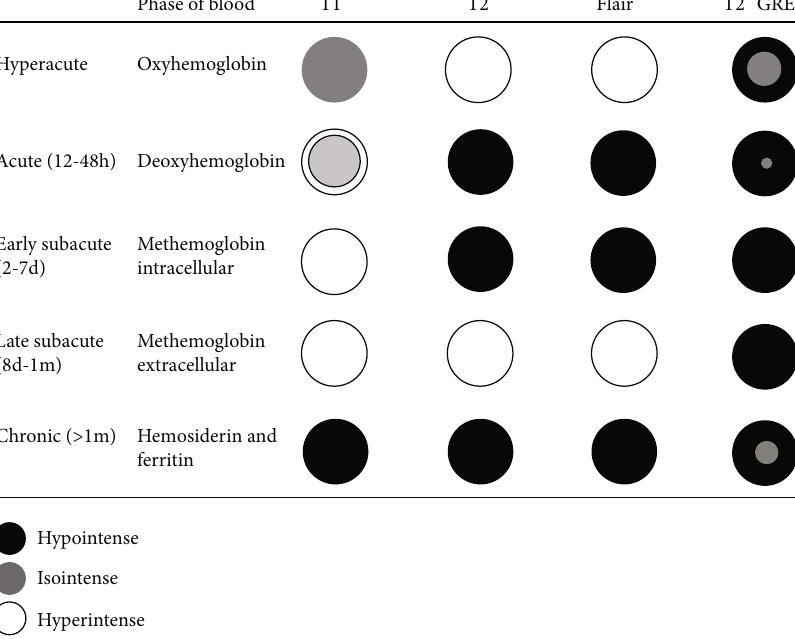
Figure 5: The evolution over time of the MRI haemoglobin aspect in hemorrhage.